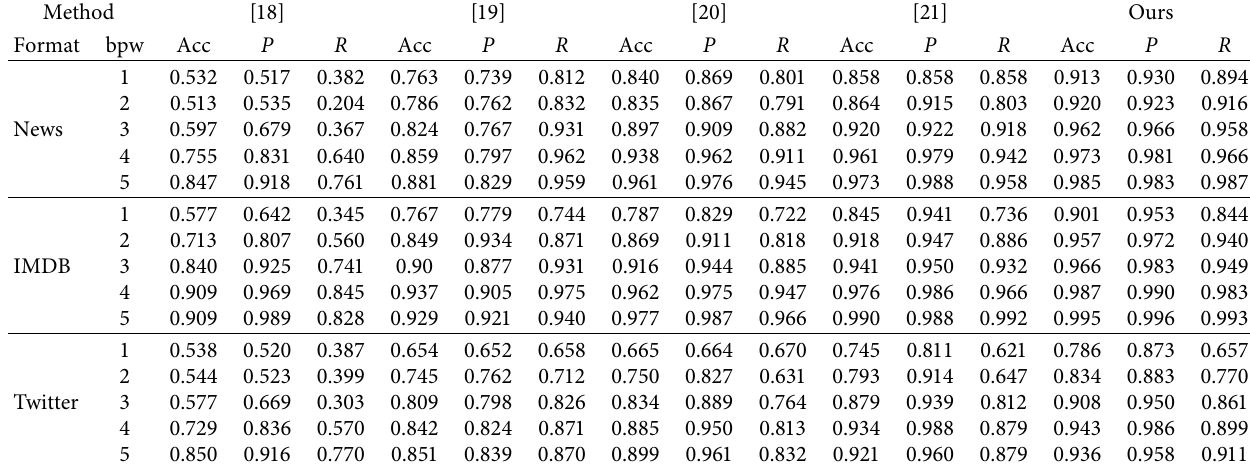
Table 1: Detection accuracy with previous linguistic steganalysis methods.